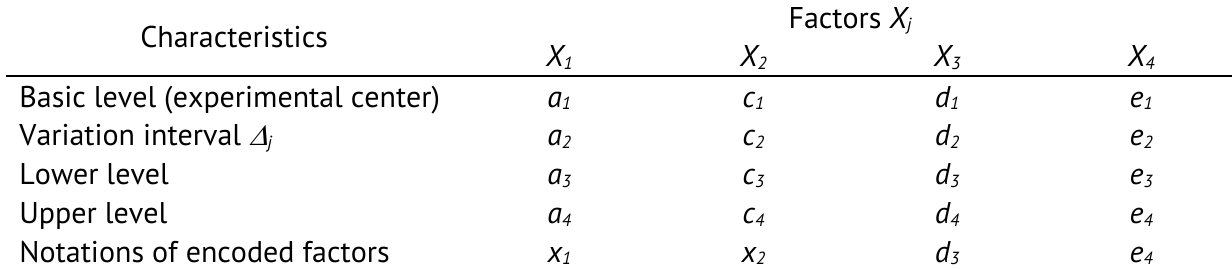
Basic characteristics of experimental